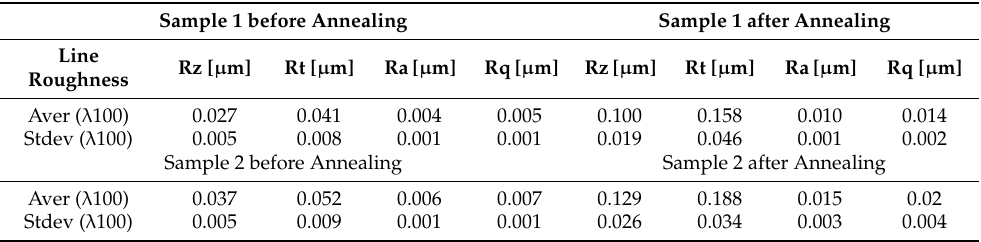
Table 4. Line roughness of samples 1 and 2 before and after